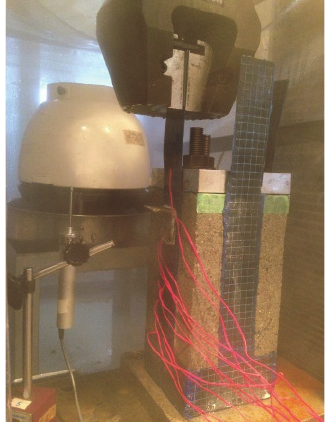
Figure 3: Specimen during the test under moisture